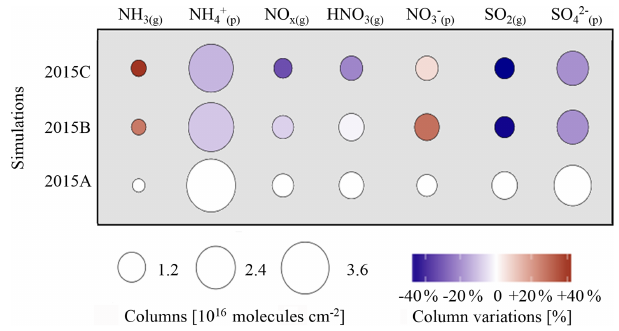
Figure 9. Gaseous and particulate inorganic species variation for the eastern China region. Disk surfaces are proportional to column amount (moleculescm − 2 ), and colours indicate relative evolution rates compared to 2015A